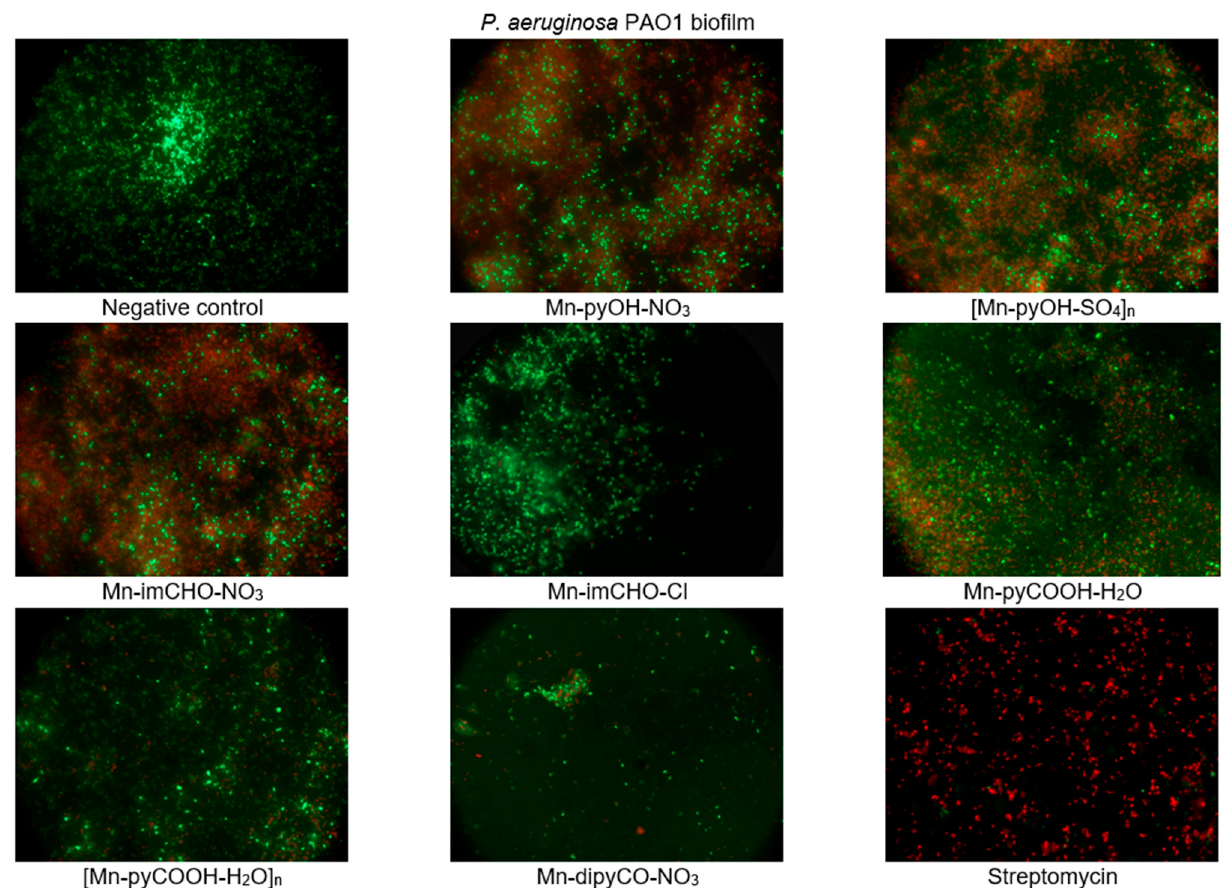
Figure 9. Epifluorescence microscopy images of P. aeruginosa PAO1 biofilm treated with 0.5 mM of the manganese complexes. Biofilm was stained with nucleic acid stains using the FilmTracer™ LIVE/DEAD Biofilm Viability kit (live cells are represented by the color green; dead cells are represented by the color red). The epifluorescence microscopy images were captured at 1000× magnification.